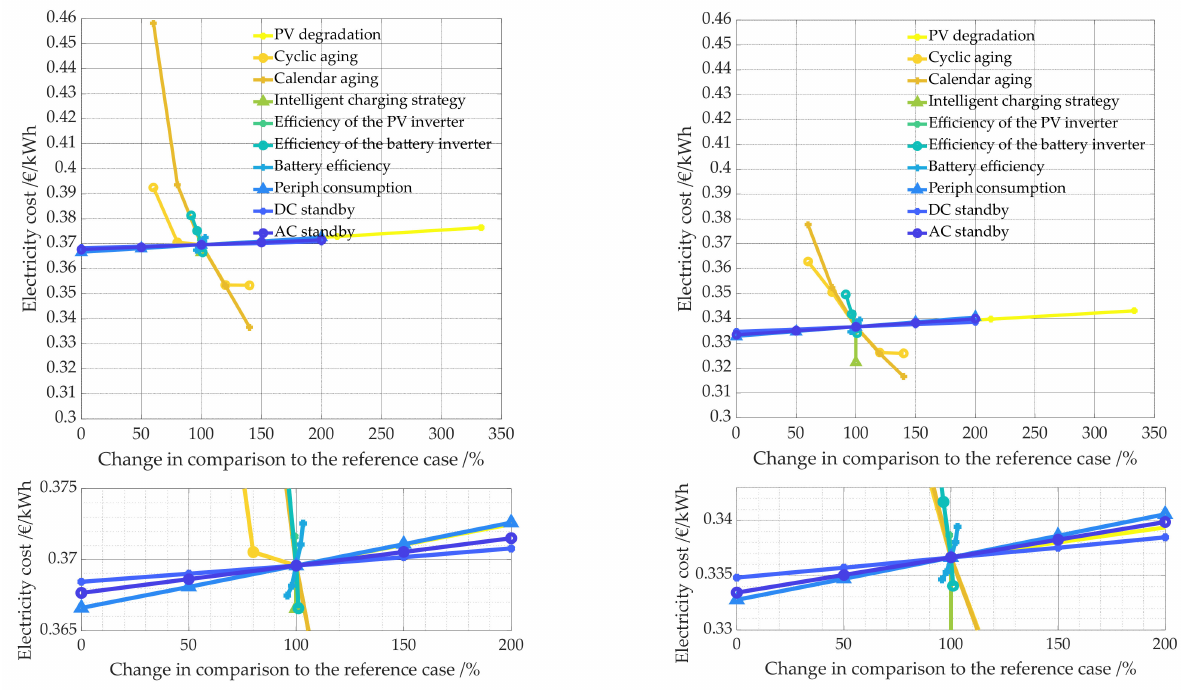
Figure 30. Impact on electricity costs due to the change in technical parameters. The left panel shows the PV system battery combination of 10 kWp and 10 kWh, the right one of 10 kWp and 5 kWh. While the upper figures show all data points, the lower figures show only parts of the data in order to better illustrate even small changes in relation to the reference